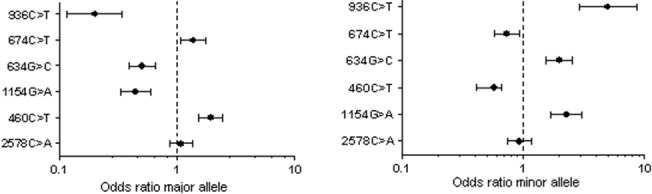
Odds ratio associated with major and minor alleles of each polymorphism.